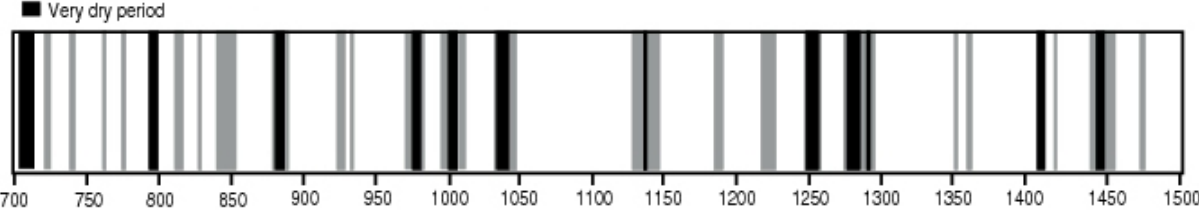
Fig. 3. Periods of extremely low in precipitation in the Mimbres region. The tree-ring precipitation reconstruction was developed by Grissino-Mayer et al. (1997), with funding from the Legacy Program, Directorate of the Environment, Natural Resources Division, Fort Bliss, Texas. Periods of extremely low precipitation were identified by Ingram ( unpublished manuscript ) using a nine-year interval running average throughout the duration of the tree-ring precipitation reconstruction (i.e., AD 622–1994). Extreme lows were defined as those intervals in the lowest quartile and decile of the distribution of all nine-year intervals in the